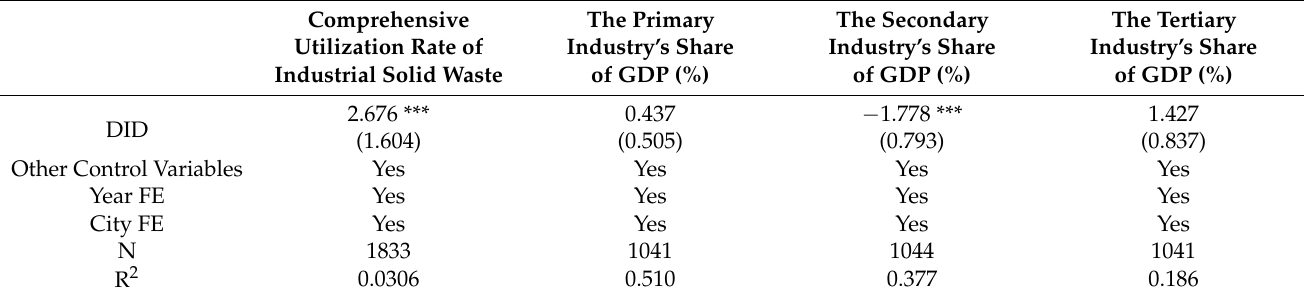
Table 7. Mechanism